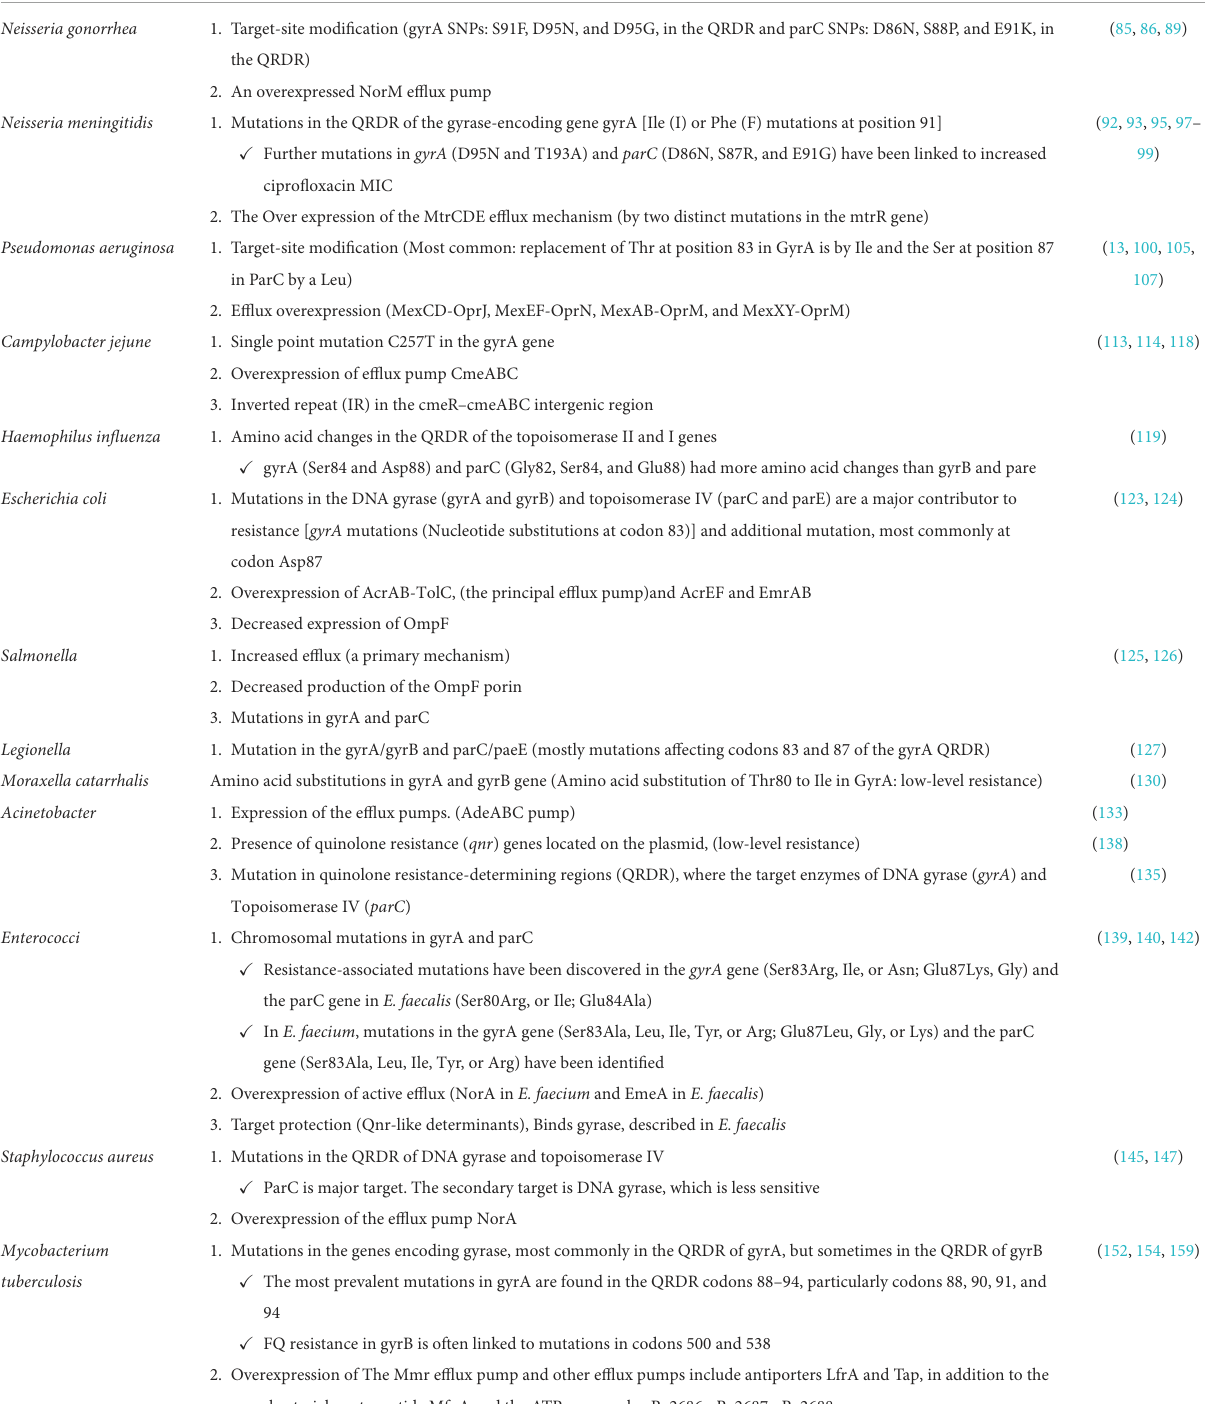
TABLE 3 Mechanisms of ciprofloxacin resistance in different